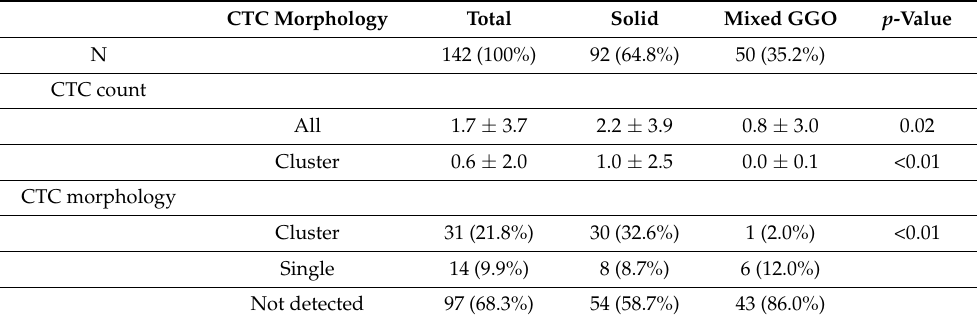
Table 2. Status of circulating tumor cells according to solid patterns on computed tomography.